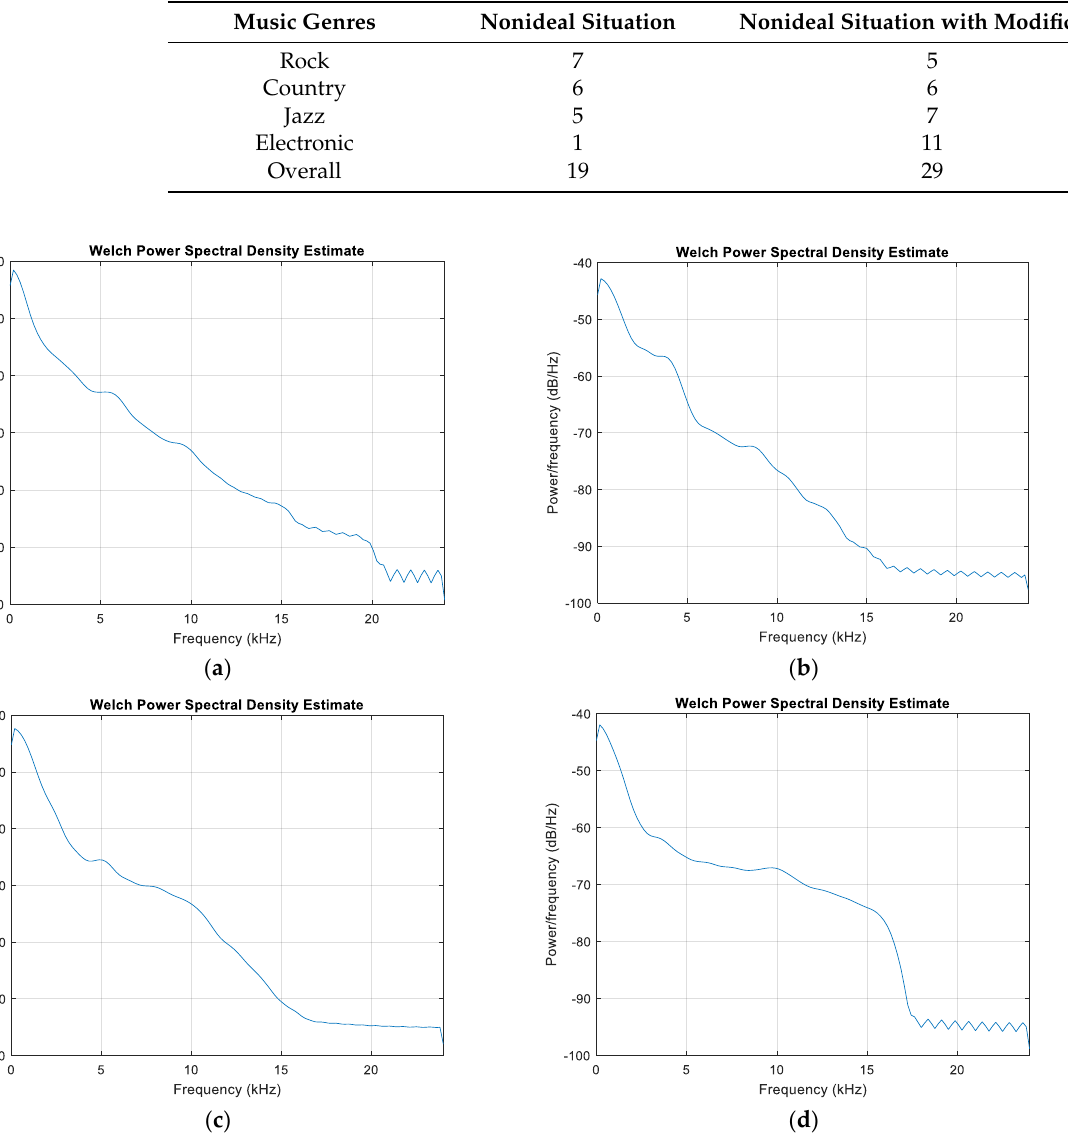
Figure 12. Power spectral density of: ( a ) rock, ( b ) country, ( c ) jazz, and ( d ) electronic music.